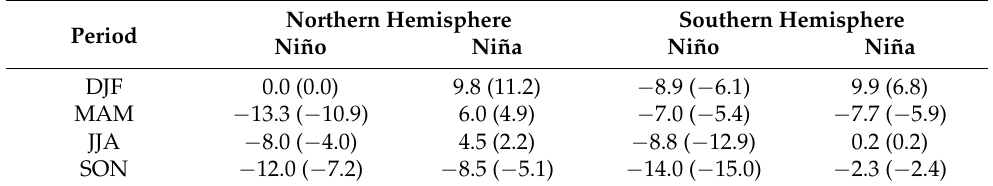
Table 2. Number of COL tracks identified in each season and ENSO phase. The percentage of tracks with respect to seasonal values is given in parentheses. Northern Hemisphere Southern Hemisphere Period Niño Niña Niño Niña